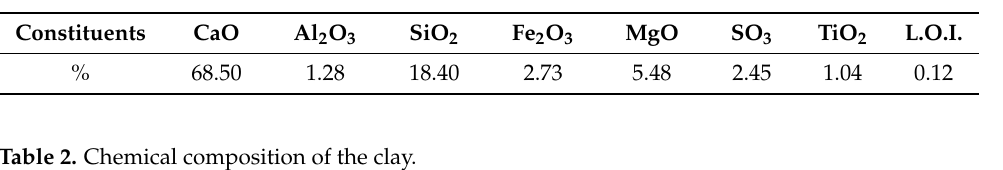
Table 1. Chemical composition of the cement.